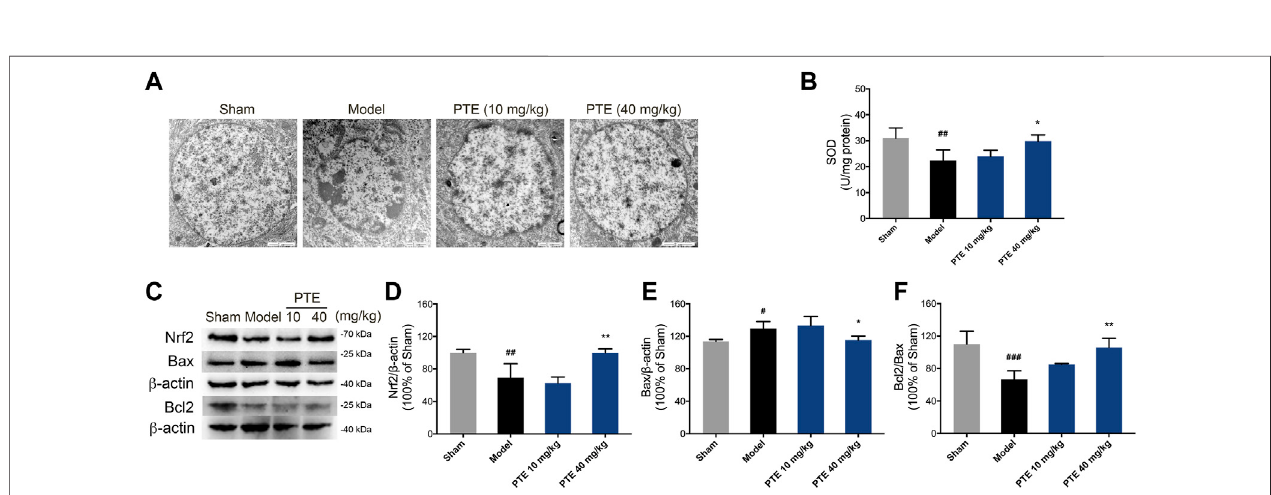
FIGURE 6 | Effects of PTE on SIRT1/Nrf2-induced antioxidant and antiapoptosis in AD mice. (A) Electron microscopy images of neuronal nuclei in the cerebral cortex. (B) The level of SOD was detected in the cerebral cortex. (C – F) Western blotting bands (C) and quantitative analysis of Nrf2 (D) , Bax (E) , and Bcl2/Bax (F) , respectively. Data are shown as mean ± SD (n = 3 – 4). # p < 0.05, ## p < 0.01, ### p < 0.001 vs sham; * p < 0.05, ** p < 0.01 vs model.